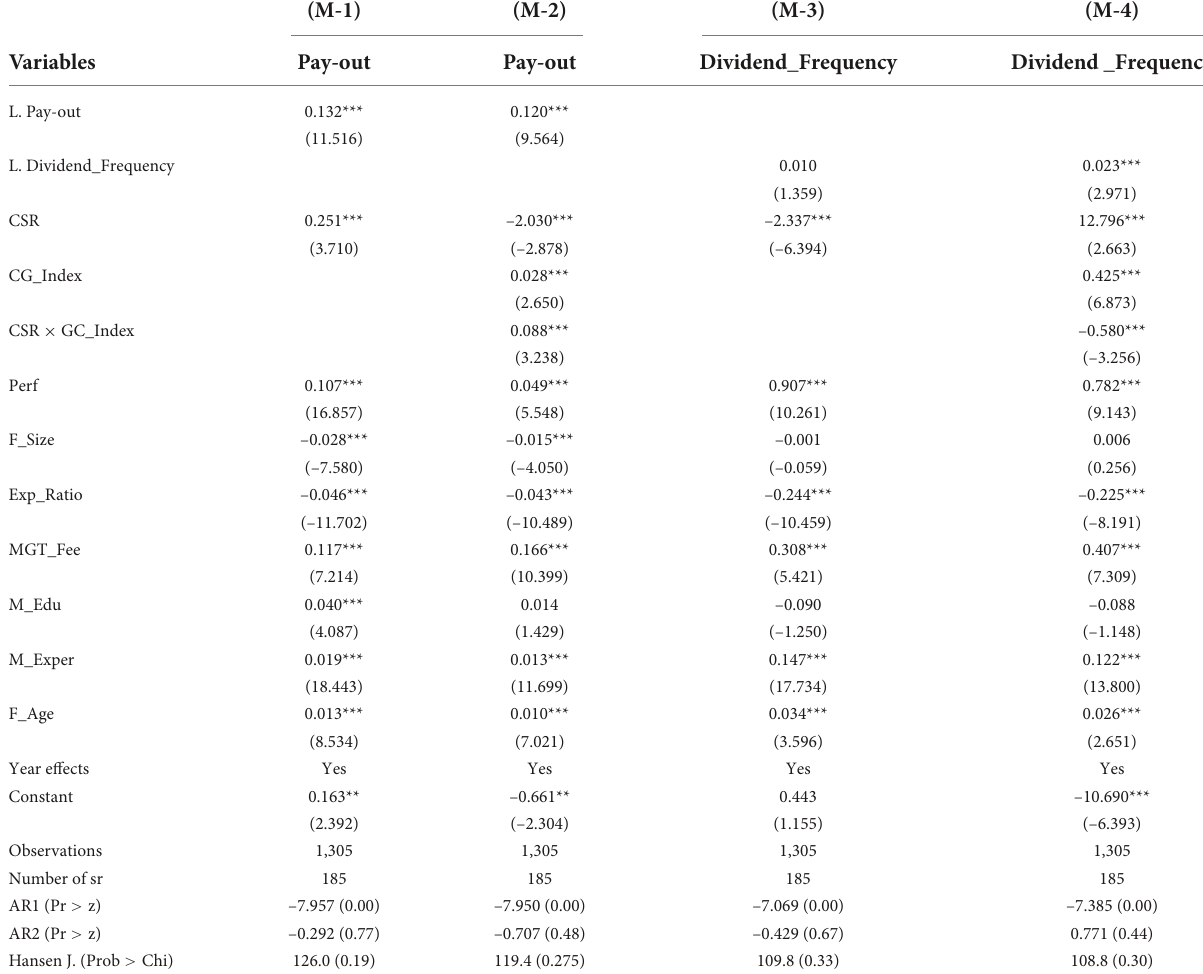
TABLE 4 Corporate social responsibility (CSR) and dividend pay-out: role of corporate